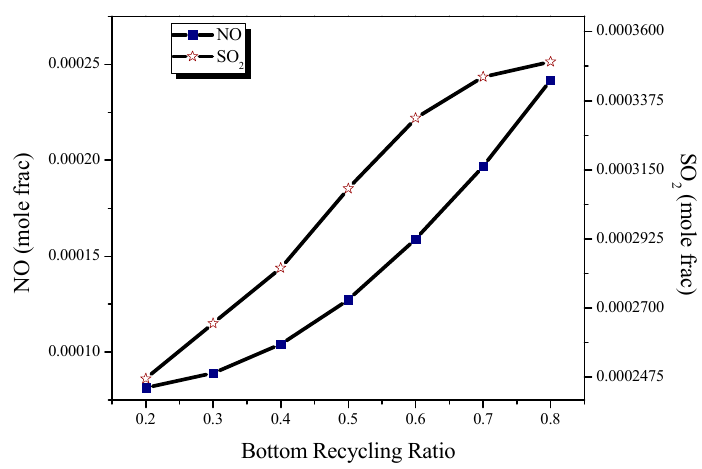
Figure 12. Effect of Bottom Recycling ratio on vapor product composition.